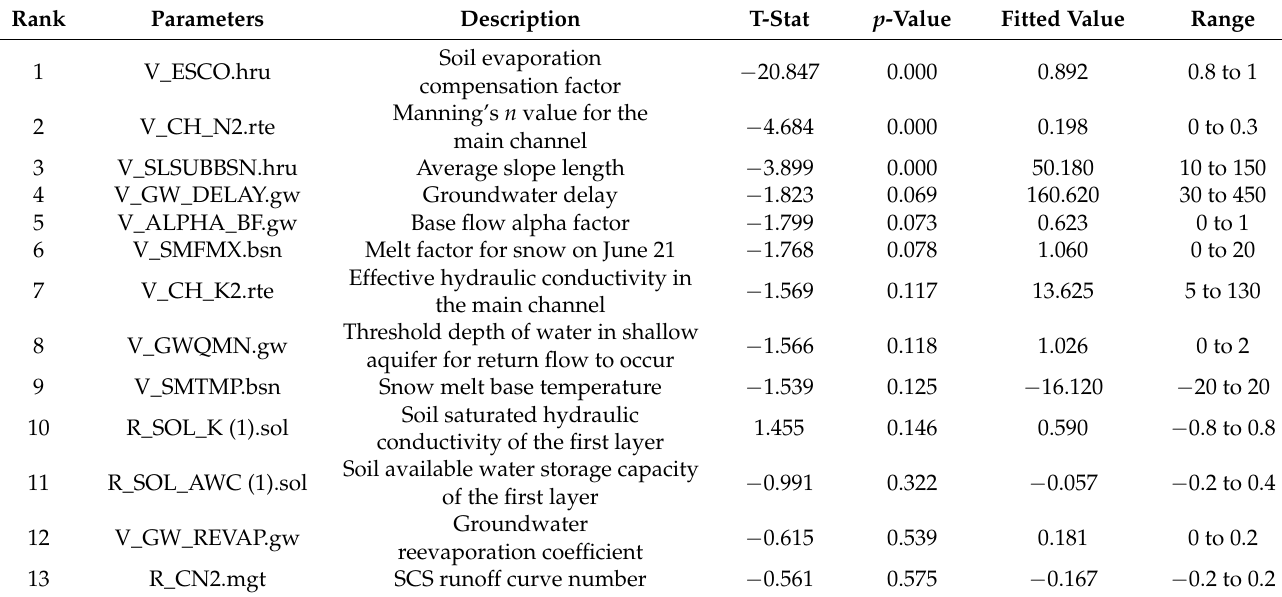
Table 2. The sensitive parameters for discharge with their ranges and fitted